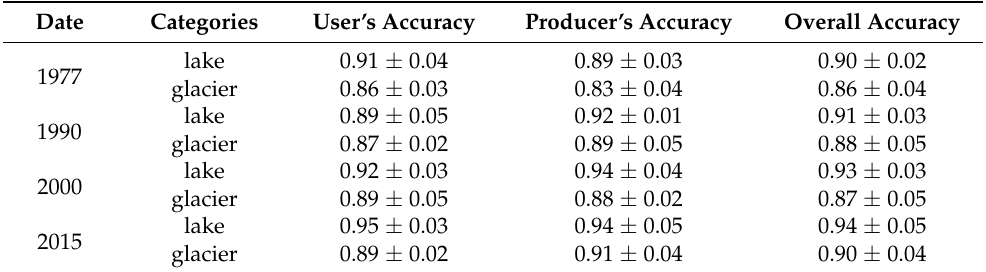
Table 3. Results of accuracy assessment of lake and glacier mapping in 1977, 1990, 2000, and